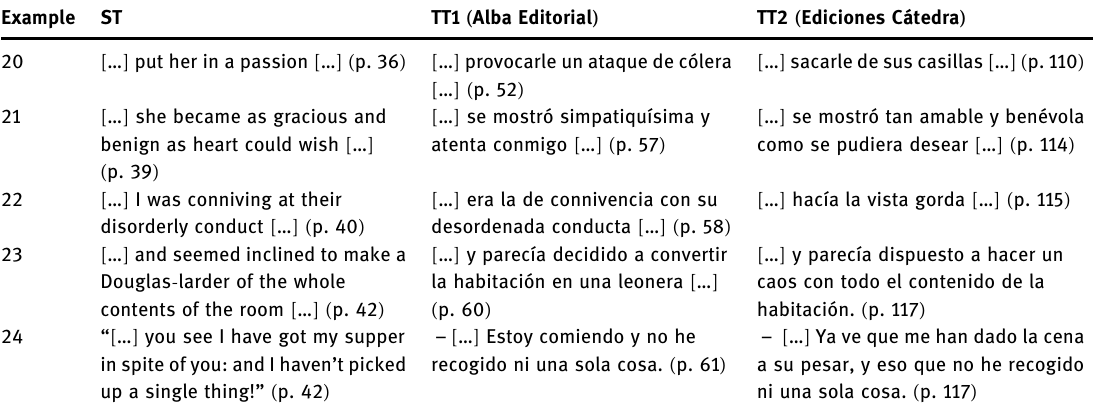
Table 4: Examples taken from Chapter 4